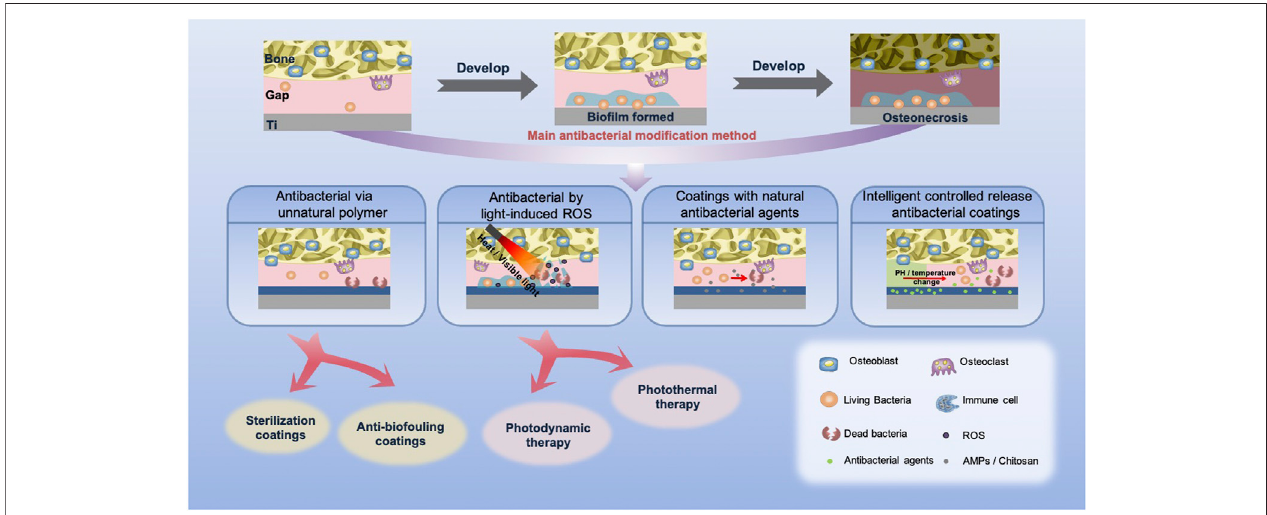
FIGURE 2 | Types and effects of antibacterial coatings of titanium implants. After implantation, bio fi lm may be formed, leading to osteonecrosis in general. At present, to avoid infection, the coatings with inactive polymers, light-induced ROS and bioactive antibacterial agents, and the intelligent controlled release antibacterial coatings are the main antibacterial